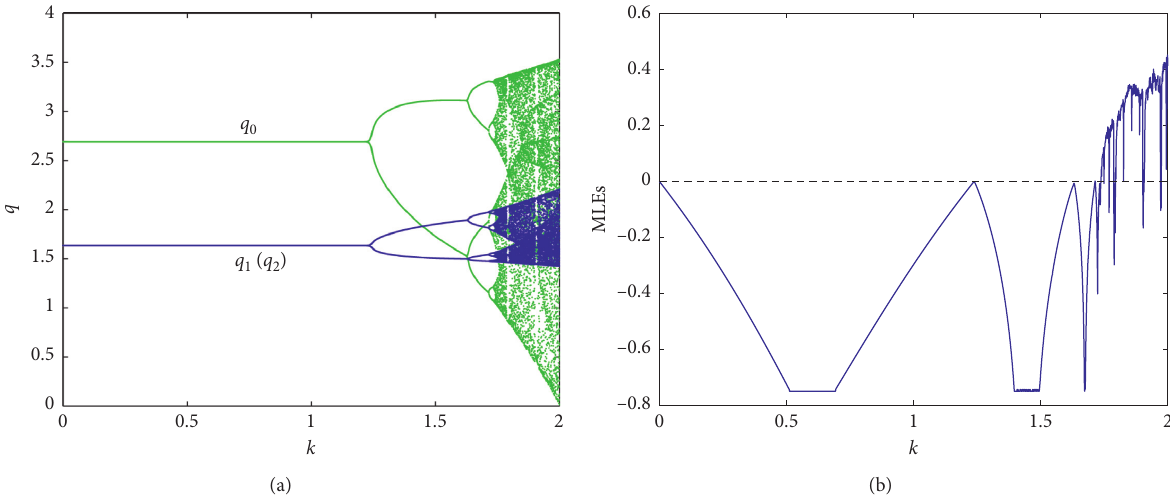
for system (11). (b) Bifurcation diagrams for system (11) with 1 with various values of δ . 0